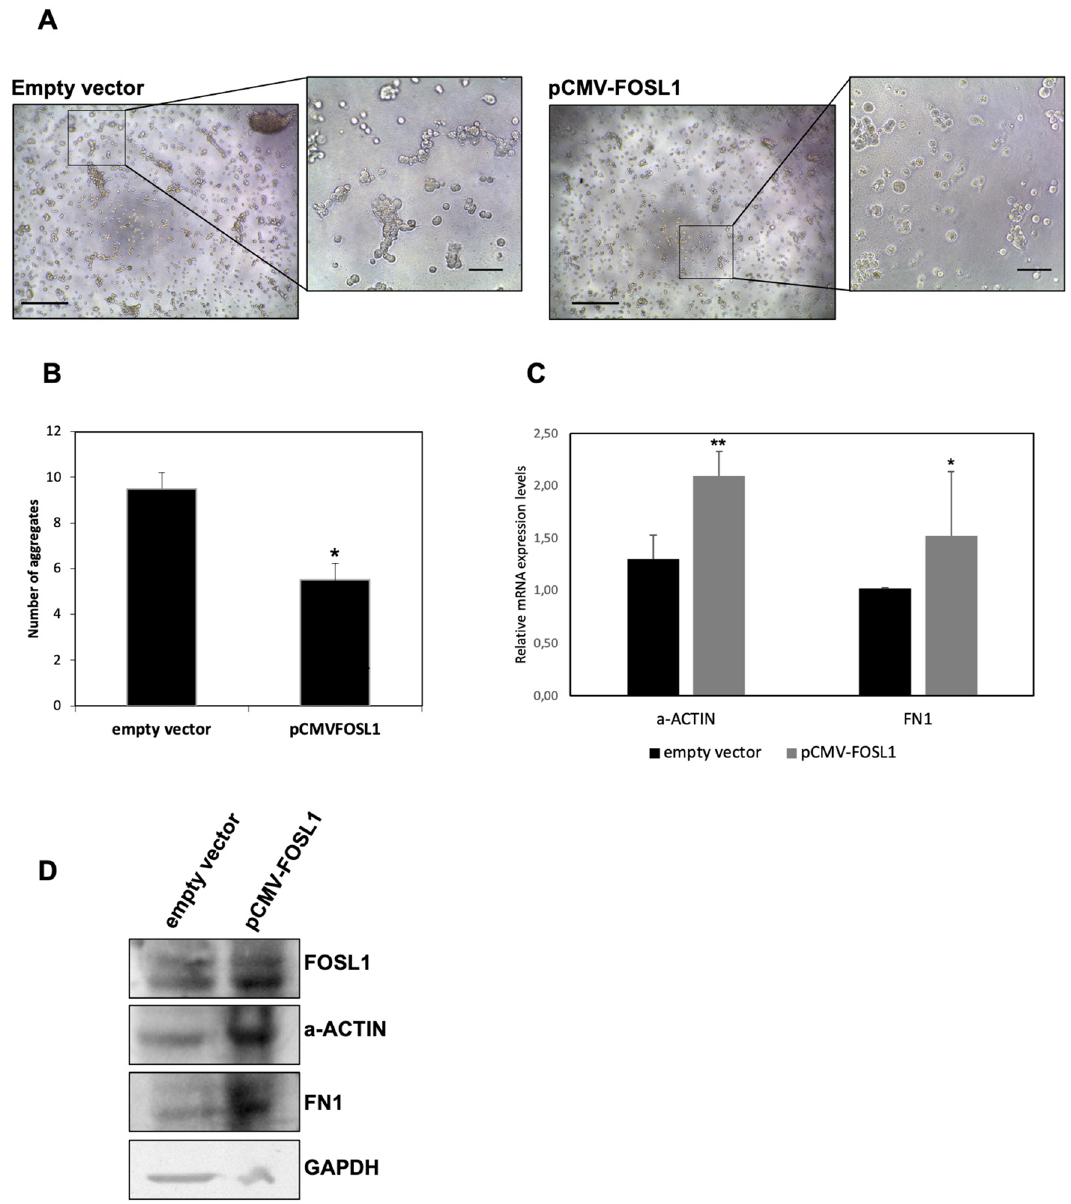
Figure 5. Cell aggregation assay. HEK293T after 1 week from the transfection with empty vector or pCMV- FOSL1 vector. ( A ) Photographs were performed at 5X magnification (scale bar length: 500 μm) and the particular were acquired at 20X magnification (scale bar length: 200 μm). ( B ) Number of aggregates in a field of view at 20X magnification ( C ) Expression analysis of a-ACTIN and FN1 in HEK293T cells after 48 h from transfection with pCMV-FOSL1 plasmid. Data are presented as mean ± standard deviation of the relative expression of each target using the GAPDH expression levels as endogenous control and the empty vector as calibrator. p value < 0.05, *; 0.005 **; 0.0005 *** (t-test data). ( D ) Protein levels in HEK293T cells after 48 h from transfection with empty vector or pCMV-FOSL1 plasmid, in the figure were reported the representative western blot of detection of FOSL1, FN1, a-ACTIN and GAPDH (used as loading